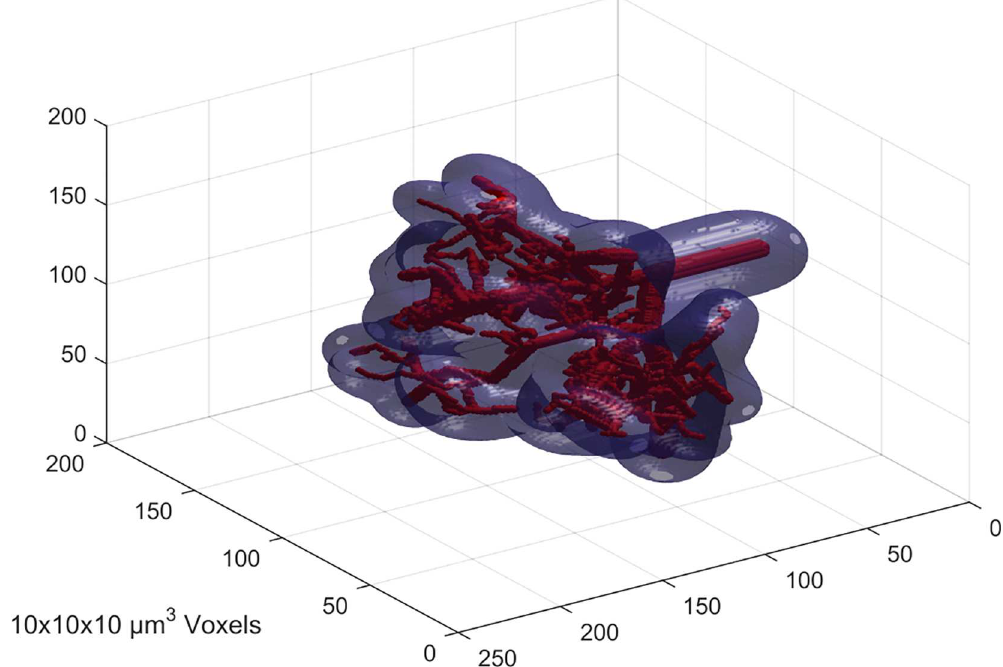
Fig 4. Microvessel tree. Microvessel tree (red) insidea semi-transparent isosurface(blue), markinga partial oxygen pressure level of 0.01